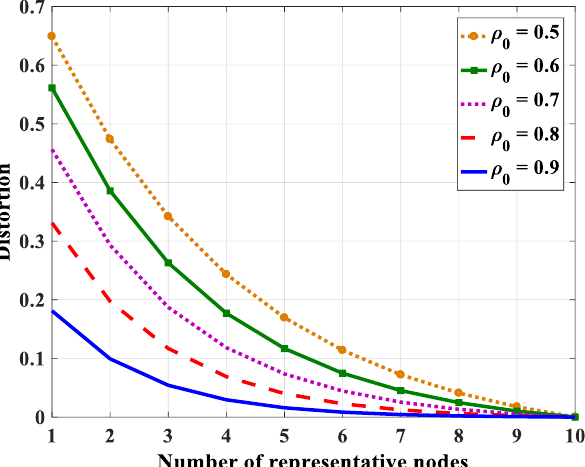
Figure 18. The relation between distortion and the number of representative nodes in the case N = 10.